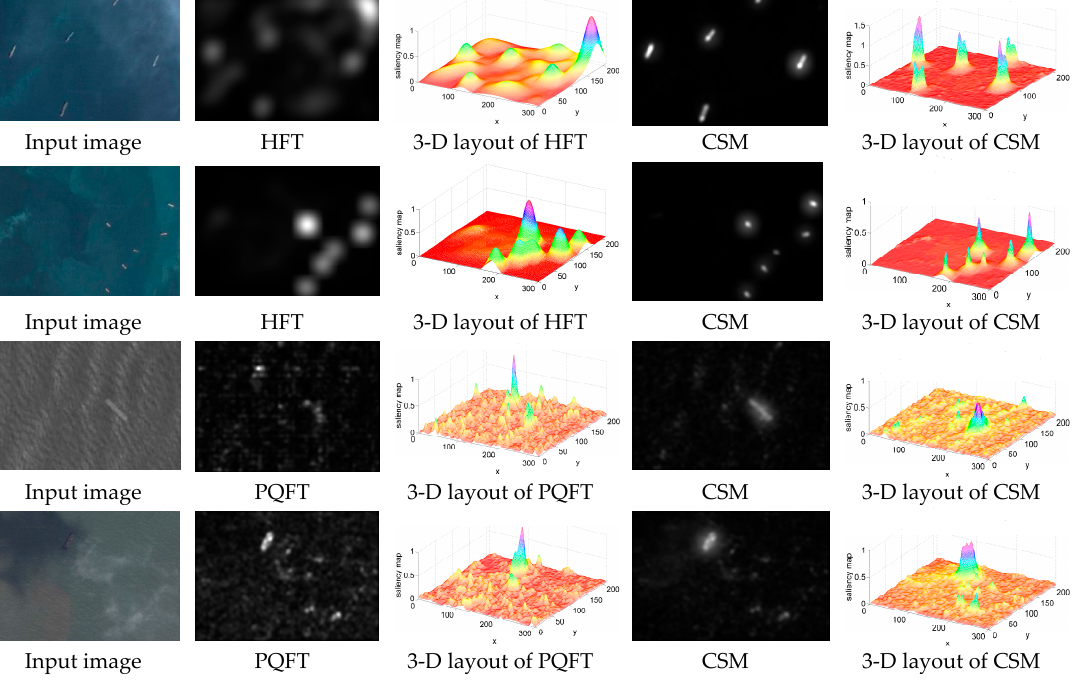
Figure 5. Visual comparisons of saliency maps.